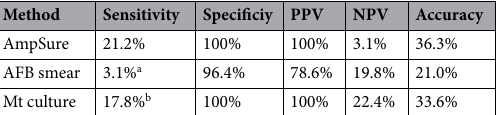
Table 3. Comparison of AmpSure, AFB smear, and culture results for pleural fluid samples. AFB, acid-fast bacilli; PF, pleural fluid; Mt, Mycobacterium tuberculosis ; a p < 0.001 compared with AmpSure, b p > 0.05 compared with